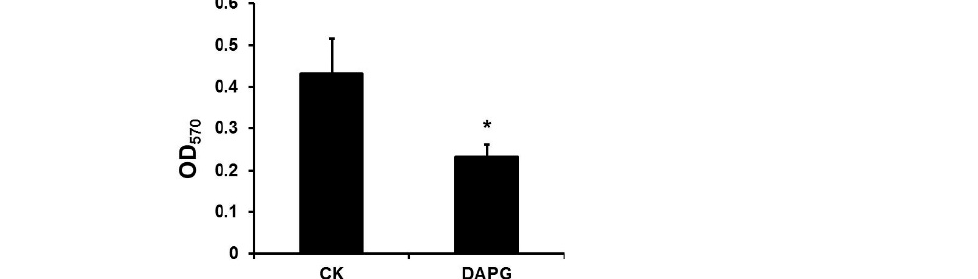
in 3 mL TSB glass tubes with 0.125 µ g/mL DAPG or methanol (CK). Biofilms were stained with